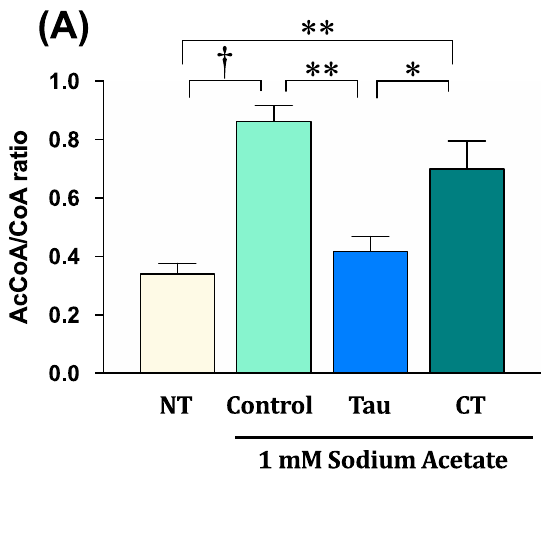
the significant differences analyzed by the one-way ANOVA post-hoc multiple comparison